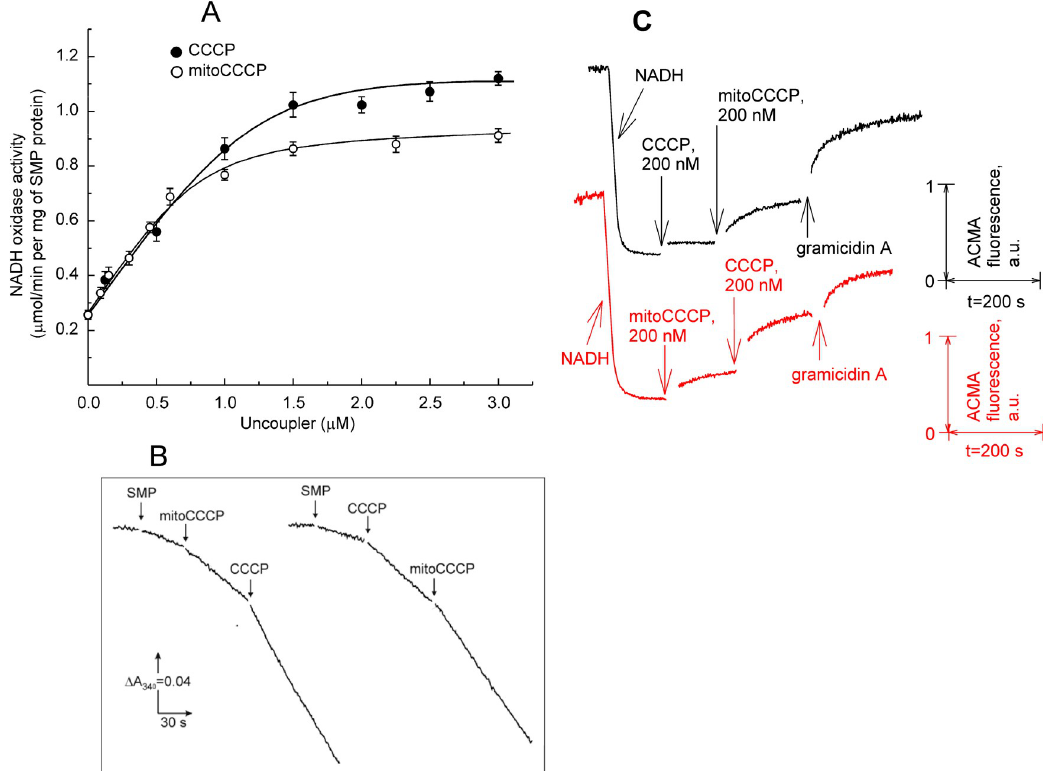
Fig 6. A . Concentration dependence of the effect of mitoCCCP (open circles) and CCCP (closed circles) on the NADH oxidation rate in submitochondrial particles (SMP). All the data are presented as mean ± SEM of at least 3 independent experiments. For experimental conditions, see Materials and methods. B . Traces of NADH oxidation by SMP in the presence of mitoCCCP and CCCP. Concentrations, left: mitoCCCP 0.45 μ M, CCCP, 2.5 μ M; right: CCCP, 1 μ M, mitoCCCP, 0.45 μ M. SMP concentration, 10 μ g/ml. C . Effect of mitoCCCP and CCCP on the pH gradient across the membranes of submitochondrial particles (SMP), as measured by ACMA (0.5 μ g/ml) fluorescence. Shown are traces of fluorescence at 480 nm (excited at 410 nm) in the medium containing 100 mM KCl, 10 mM HEPES, 5 mM MgCl 2 , 0.5 mM EGTA, pH 7.4. In the traces, 200 μ M NADH was supplemented at t = 150 s. 1 μ g/ml of gramicidin A was added at the end of each trace. Protein concentration was 25 μ